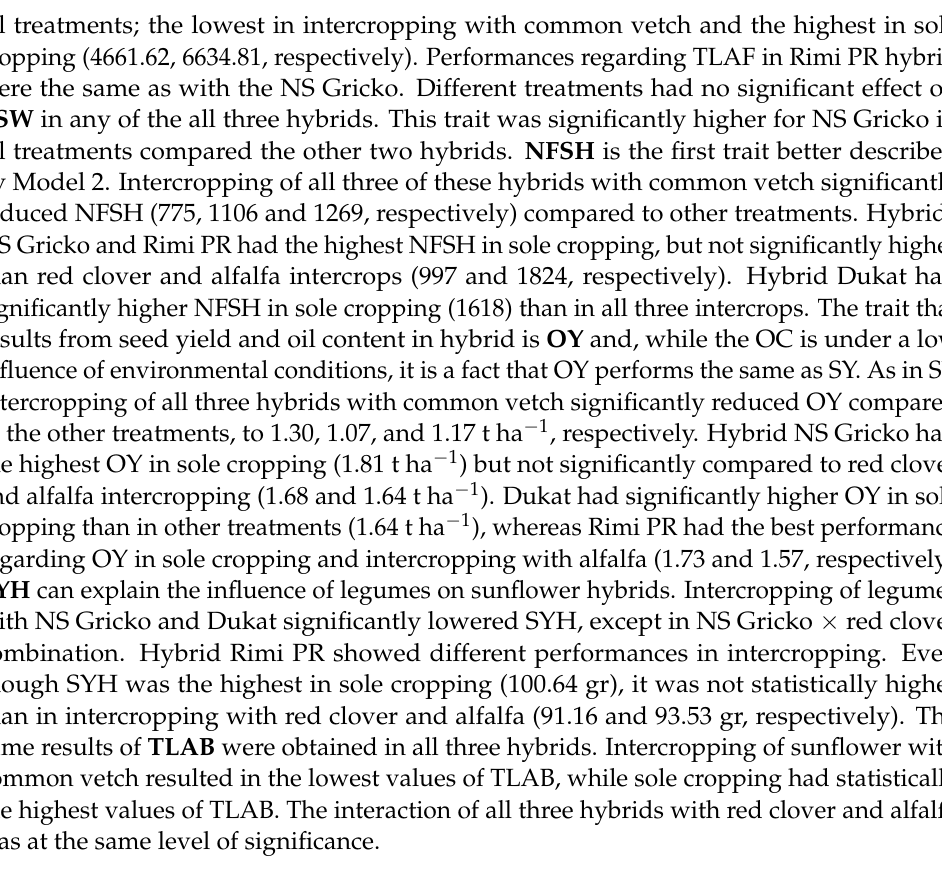
Table 3. Test of fixed effects for LMM analyses for sunflower traits analyzed in sunflower legumes intercropping. Source of